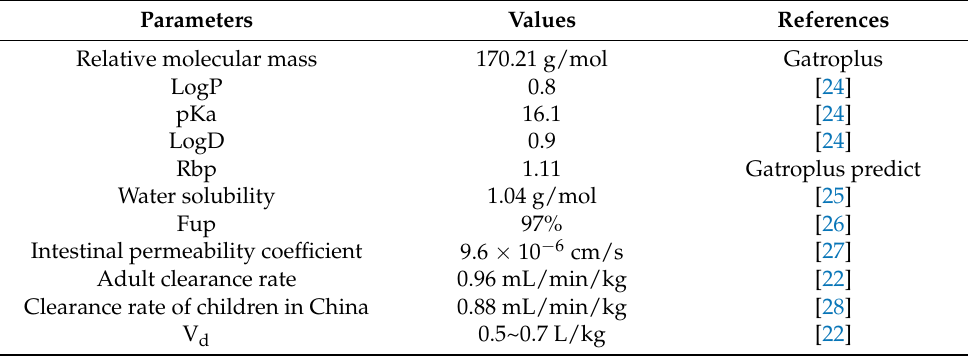
Table 1. Physicochemical and biopharmaceutical parameters of LEV.